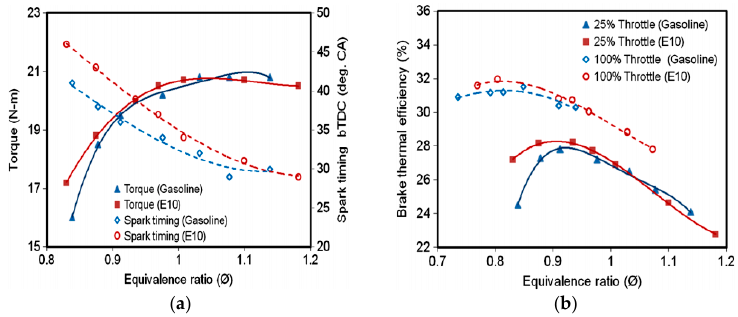
Figure 3. The variation of ( a ) Torque ( b ) Brake thermal efficiency versus equivalence ratio, at a fixed speed of 2500 rpm and 25% throttle opening. Reprinted and adapted with permission from Ref. [67]. Copyright (2012) John Wiley and Sons.